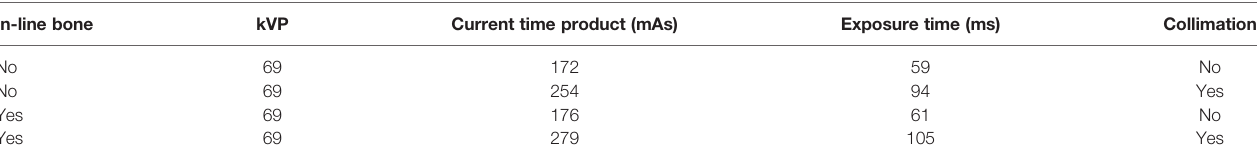
TABLE 2 | Settings of the X-ray machine for the different acquisitions of fi ducial marker images at HIT. In-line bone